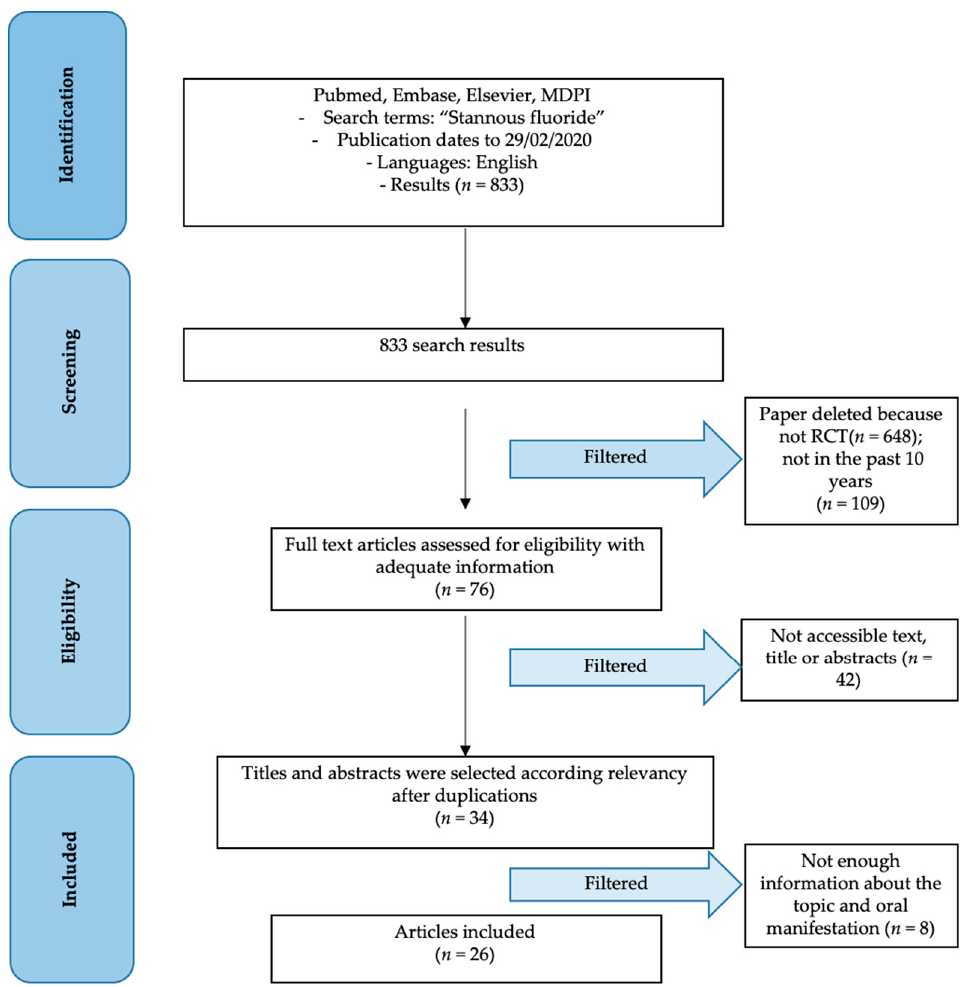
Figure 2. PRISMA flow chart.